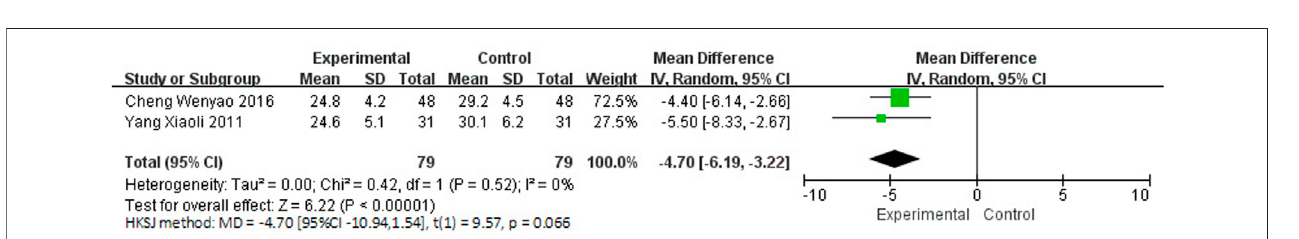
FIGURE 8 | Meta-analysis of BI by NBP as combination therapy.